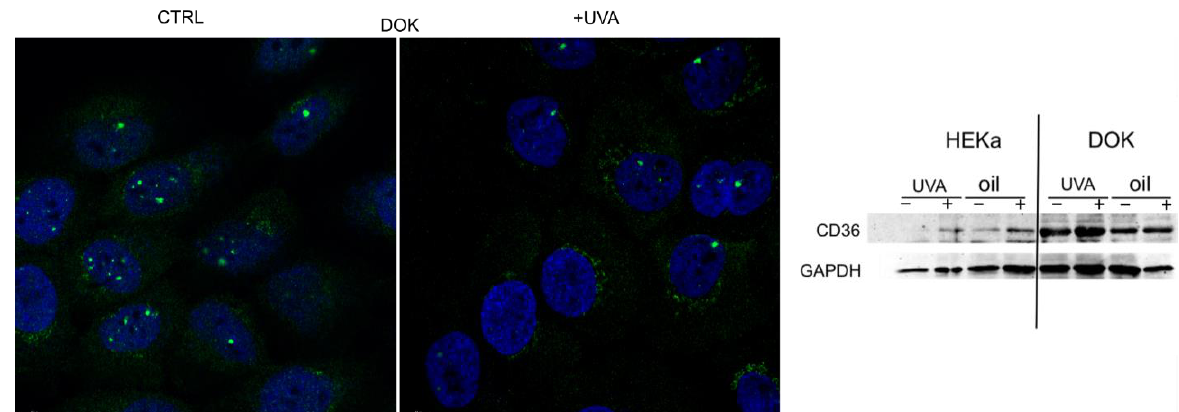
Figure 6. CD36 expression in normal (HEKa) and dysplastic (DOK) keratinocytes after UVA irradiation. Expression of CD36 in both HEKa and DOK cells was assessed by confocal immunofluorescence and confirmed by Western blot. In basal conditions, CD36 expression in normal keratinocytes is undetectable with the selected methods. Its expression increases in dysplastic cells, as well as following UVA irradiation.